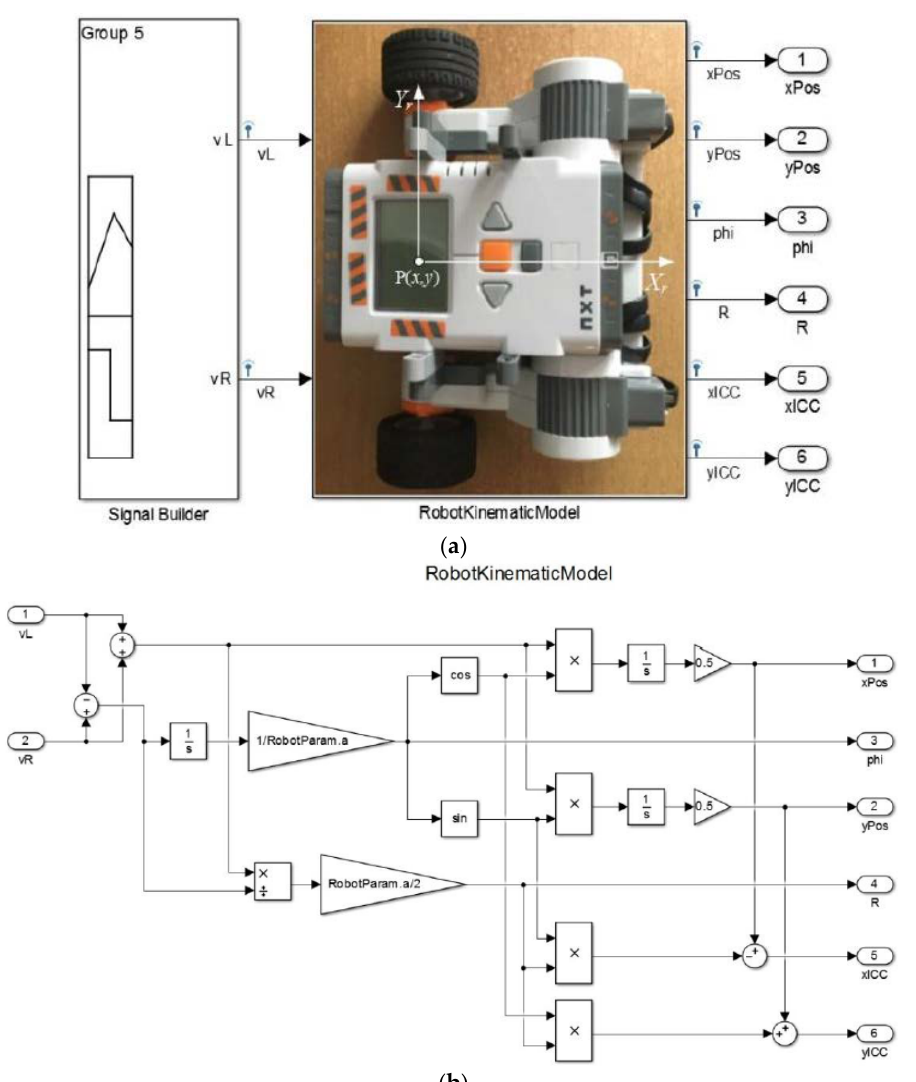
Figure 4. Robot kinematics model created in Simulink: ( a ) general view, ( b ) simulink realization of kinematic equations describing robot location [12].